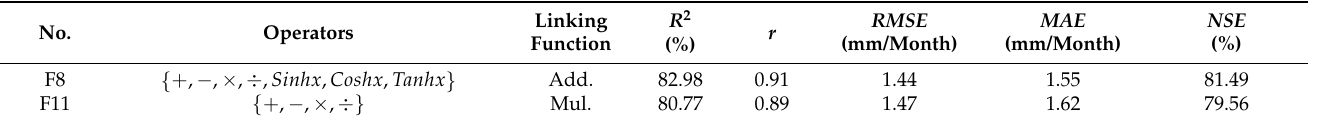
Table 6. Results of the GEP for the best operators under the Add. and Mul. linking functions (Appendix A.2).